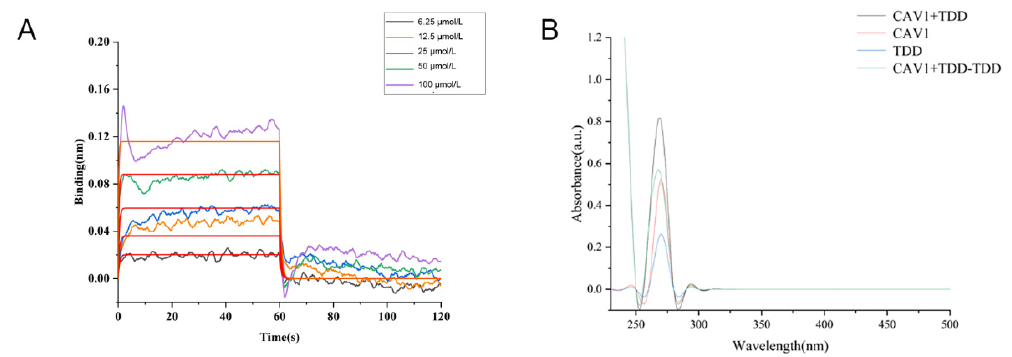
Figure 7. ( A ) BLI analysis of TDD binding to Cav1, ( B ) UV-vis absorption Spectra of TDD and Cav1 system. The fluorescence spectra of Cav1 in the absence or presence of TDD at 298 k or 310 K are represented in Figure 8A,B. The maximum emission peak of Cav1 was at 340 nm. The intensity of this peak decreased with increasing concentration of TDD.